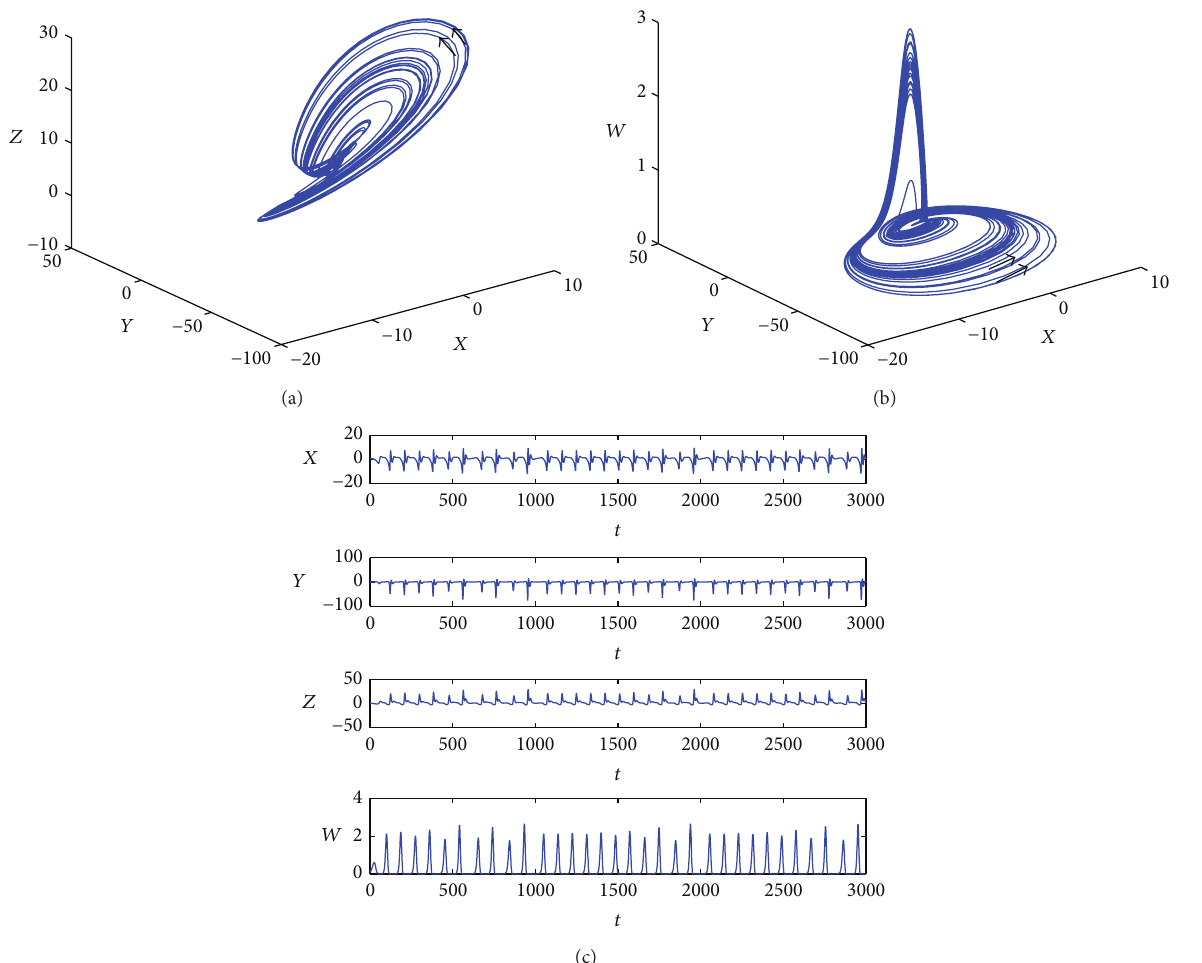
Figure 4: A chaotic attractor of system (1): (a) a 3D view ( 𝑋 - 𝑌 - 𝑍 ), (b) a 3D view ( 𝑋 - 𝑌 - 𝑊 ), and (c) the time series of 𝑋(𝑡),𝑌(𝑡),𝑍(𝑡),𝑊(𝑡) .